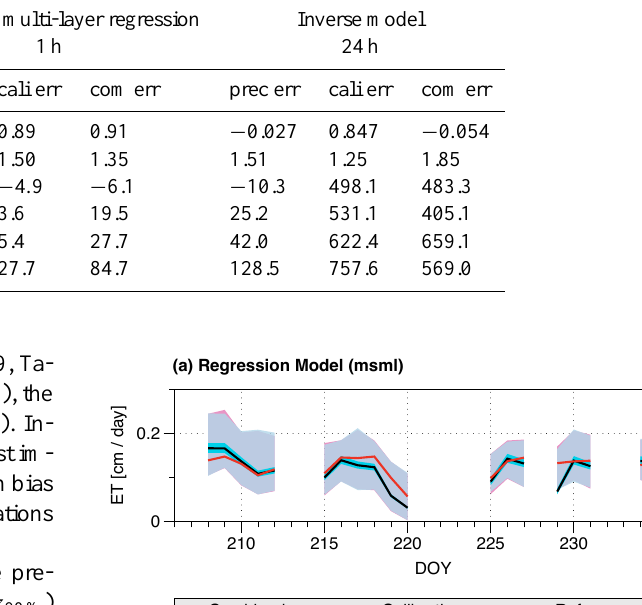
Table 4. Comparison of the model performance with considering soil moisture measurement uncertainties for the msml regression and the im for reproducing daily evapotranspiration and the mean depths where 25, 50 and 90% water extraction occurs. The model performance is expressed as correlation coefficient ( R ), relative variability in simulated and reference values (RV) and relative bias ( b ) for the period 25 July to 26 August 2009. The precision uncertainty is abbreviated as prec err, the calibration uncertainty as cali err, and the combined uncertainty as com err. The relative bias for reproducing evapotranspiration is abbreviated as b ET , and is abbreviated as b 25% , b 50% and b 90% for reproducing mean depths where 25, 50 and 90% water extraction occurs, respectively.